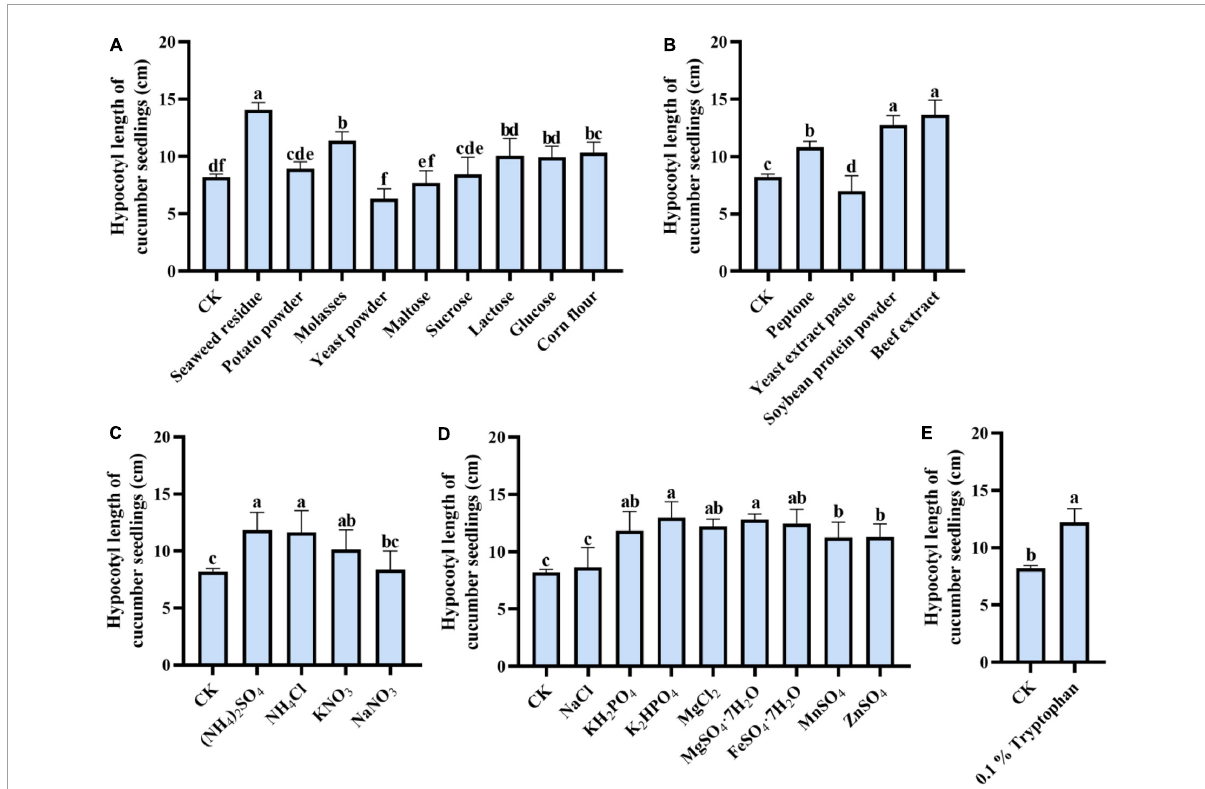
FIGURE4 One-factor-in-a-time method for the significant medium component screen. (A) Each of various carbon sources, (B) each of various organic nitrogen sources, (C) each of various inorganic nitrogen sources, (D) each of various inorganic salts (E) 1 % tryptophan on the growth-promoting ability of co-fermentation broth. The cucumber hypocotyl length and the response value were represented, respectively. The experiments were done in quintuplicate. The error bars were represented in the graph; standard deviation and mean were determined ( P < 0.05) using Tukey’s HSD test. Different lowercase letters indicate the significant differences between the treatments.